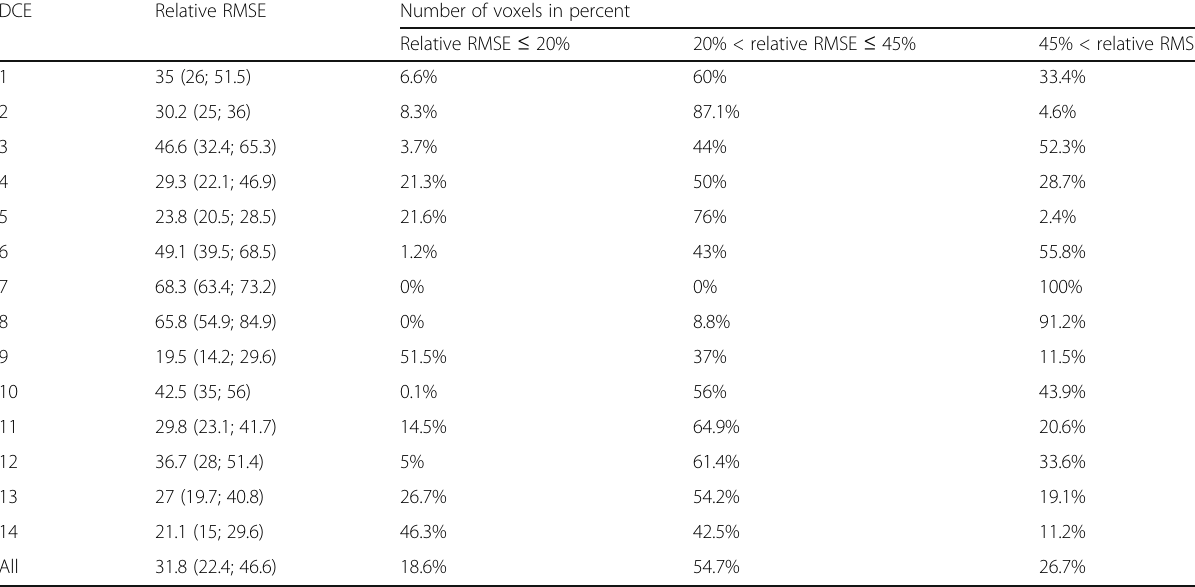
Table 4 Curve fitting metrics for DCE kinetic